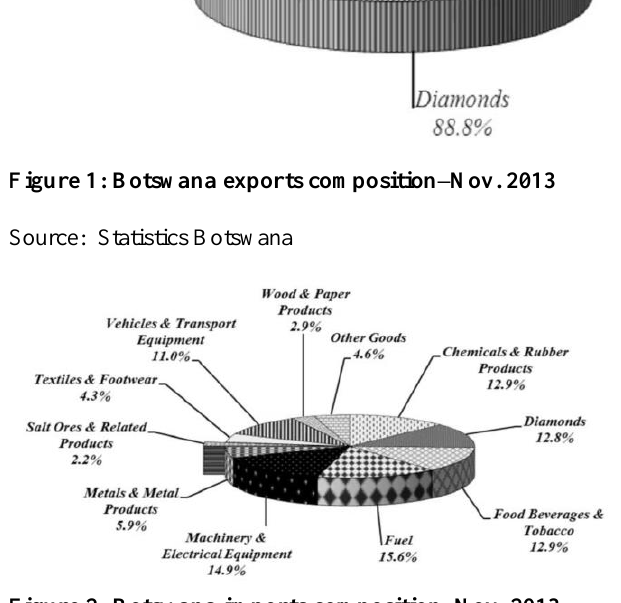
Figure 2: Botswana imports composition–Nov. 2013 Source: Statistics Botswana